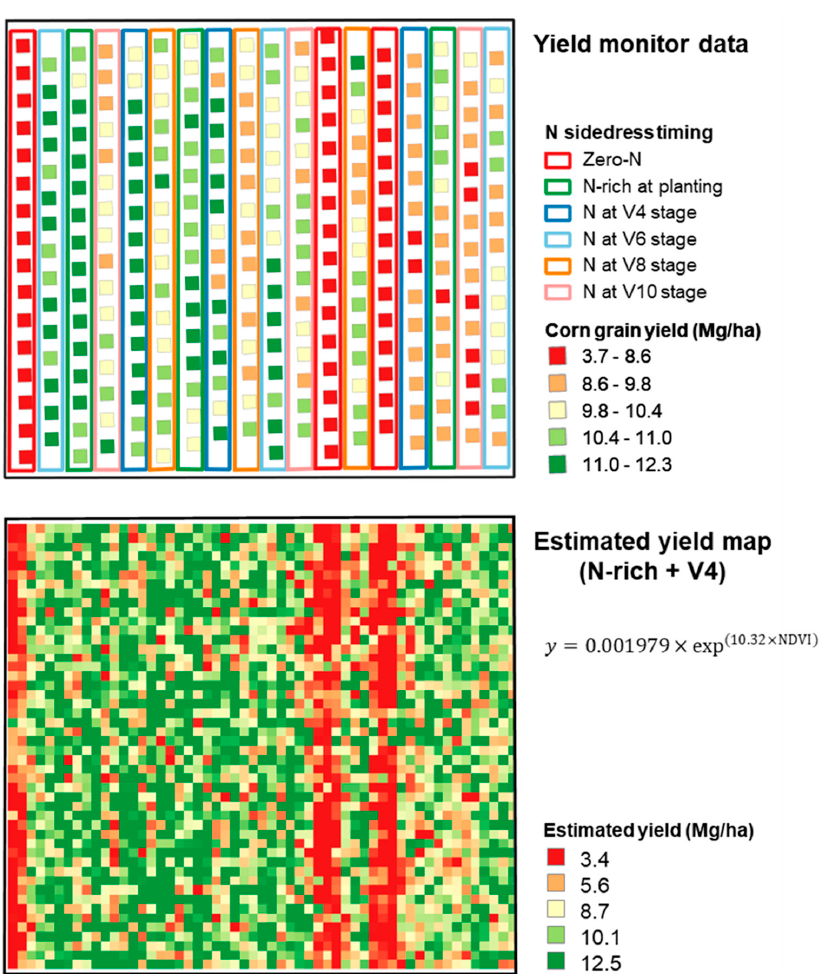
Figure 11. The actual corn yield map (yield monitor system) compared with yield maps estimated based on NDVI from N-rich and V4 plots, using a raster calculator at 1 m/pixel spatial resolution.